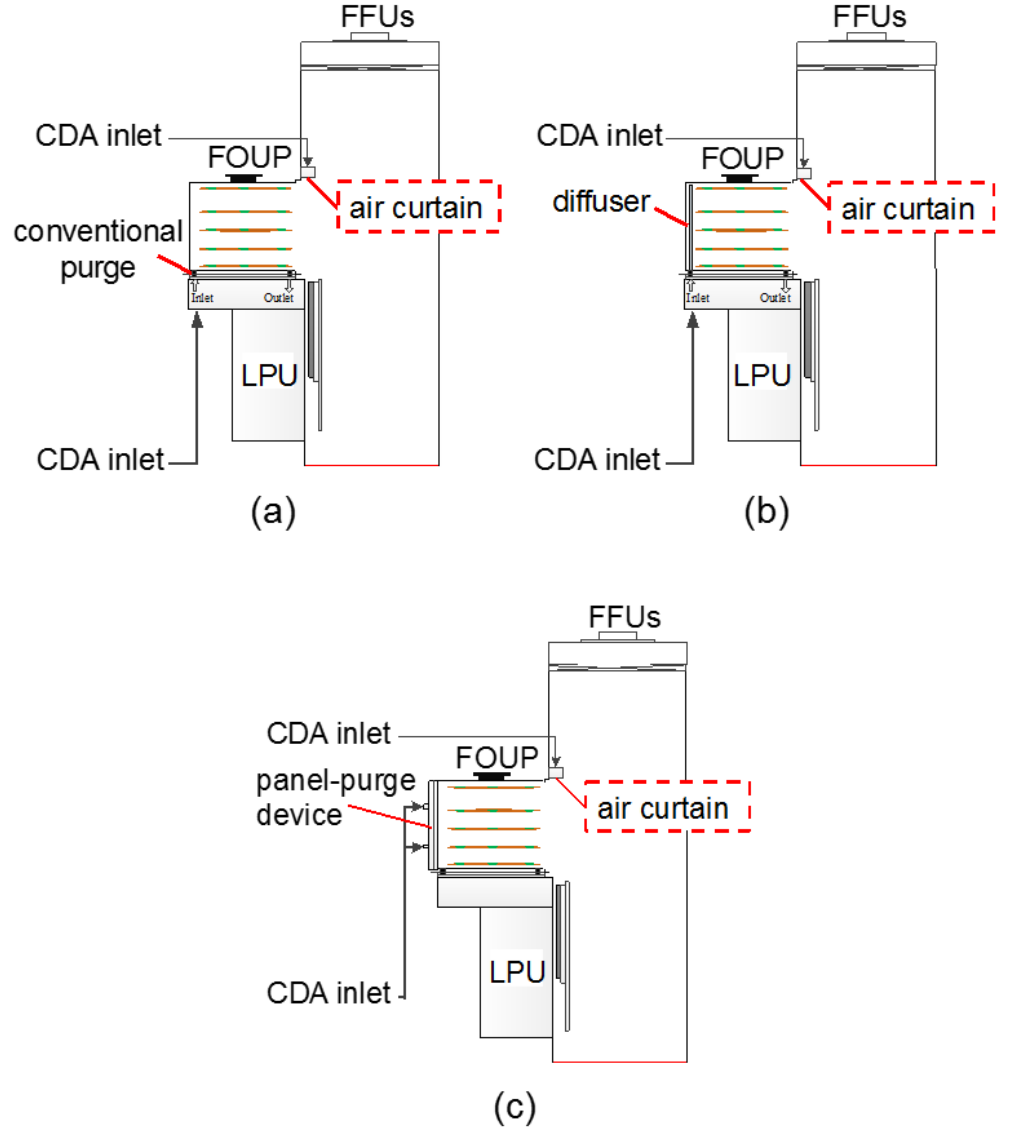
Figure 6. Testing loops for different purge methods in FOUP: ( a ) conventional purge, ( b ) diffuser purge, and ( c ) panel